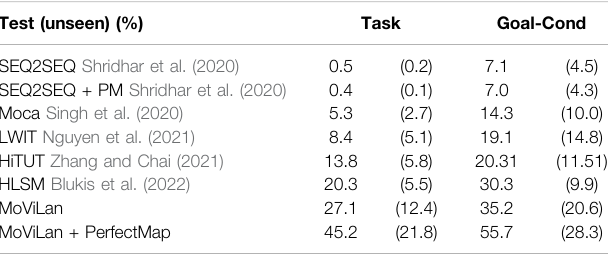
TABLE 1 | Task and Goal-Condition success percentages (rounded to nearest integer percentage). Results for the corresponding path weighted metrics are provided in parenthesis.